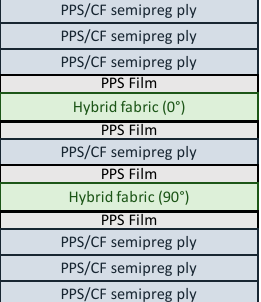
Figure 2. Lamination sequence of hybrid samples (not in scale).